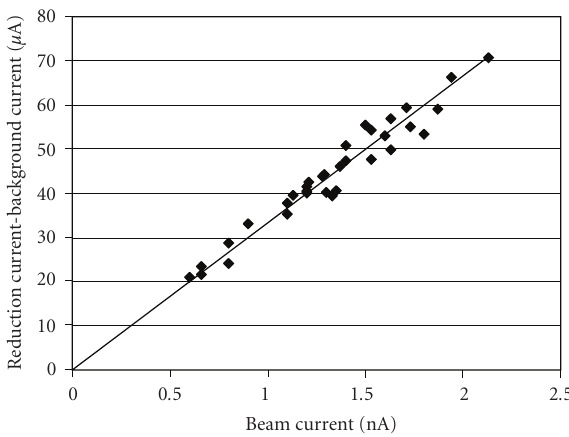
Figure 4: Steady-state electrochemical response of 0.01M KOH exposed to an alpha beam of various beam